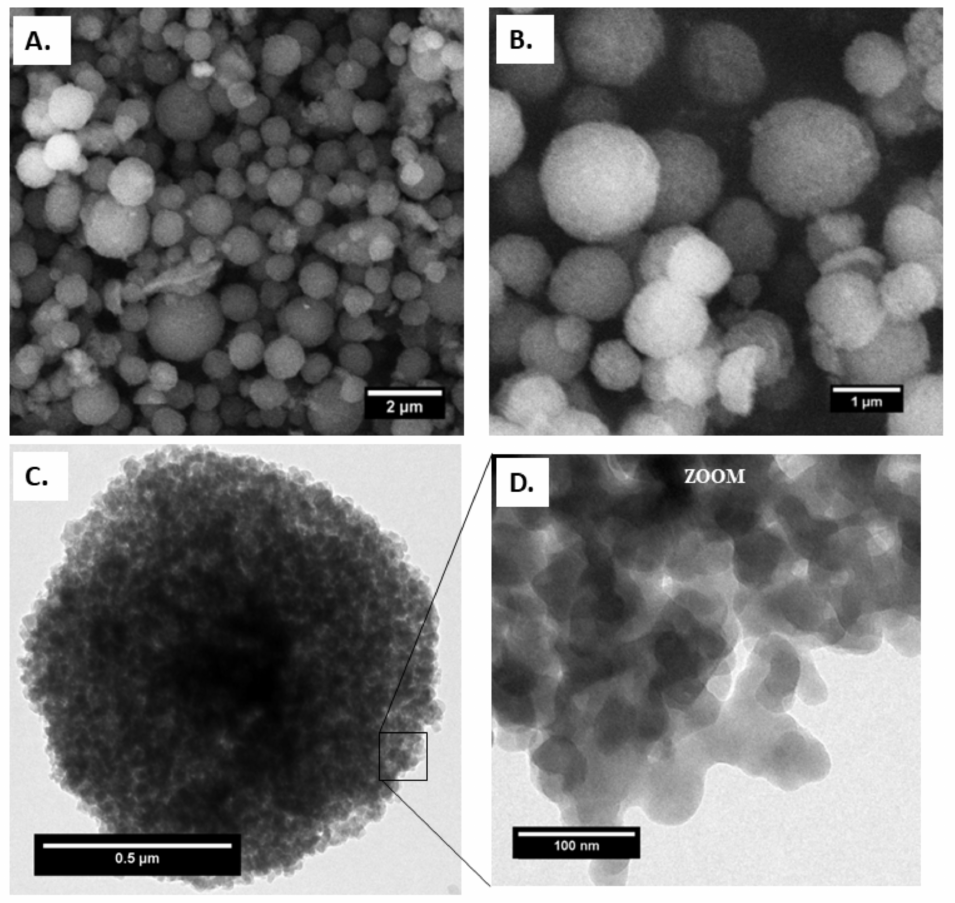
Figure 1. ( A ) and ( B ) field emission gun scanning electron microscopy (FEGSEM), ( C ) transmission electron microscopy (TEM) images of capsules and ( D ) MIL-100(Fe) NPs on the capsule surface. The resulting MIL-100(Fe) capsules preserved the crystallinity of MIL-100, as con- firmed by PXRD and FTIR studies, in comparison with the pre-formed MIL-100(Fe) NPs (Figures S3 and S4). Nitrogen physisorption measurements on the capsules indicated a porosity similar to that of the bare nanoparticles, with a measured surface area of 1613 m 2 g − 1 , with micropore and mesopore volumes of 0.64 (calculated via t-plot) and 0.85 cm 3 g − 1 (calculated via